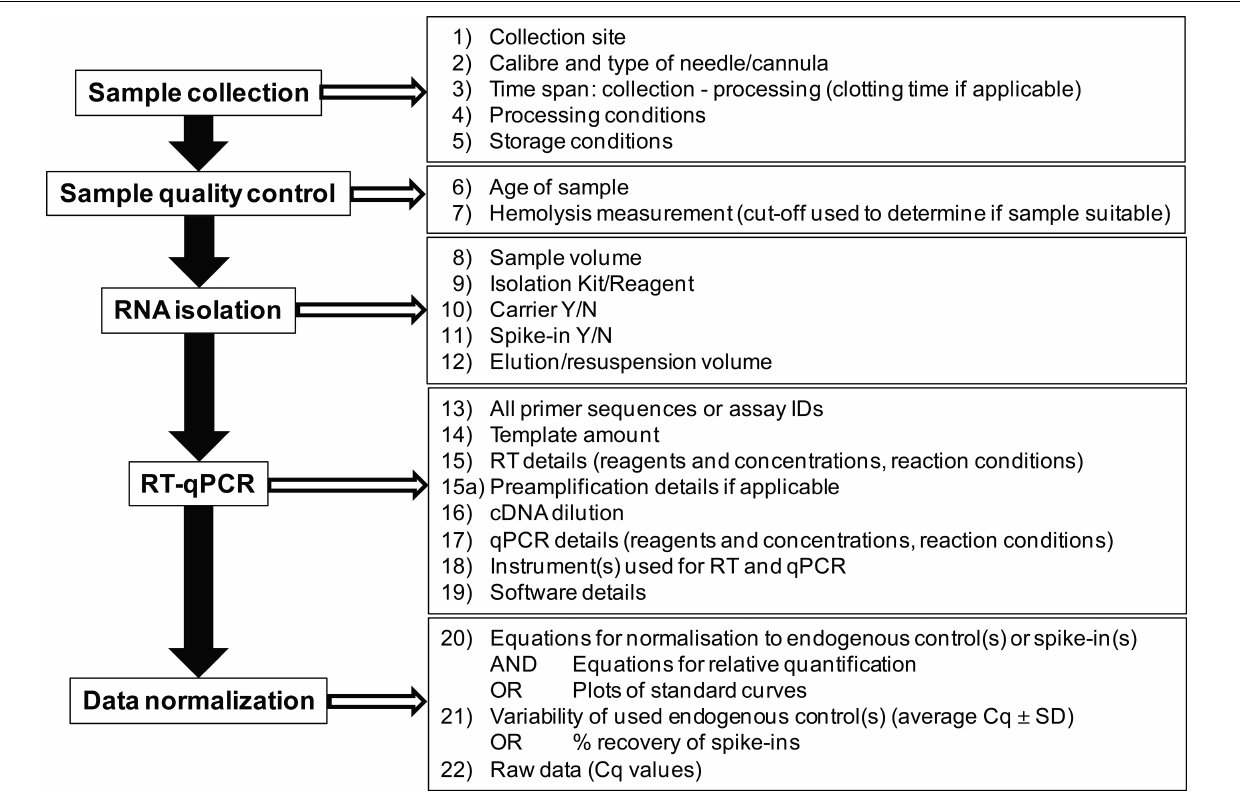
FIGURE 2 | Summary of details that should be provided when reporting on cell-free